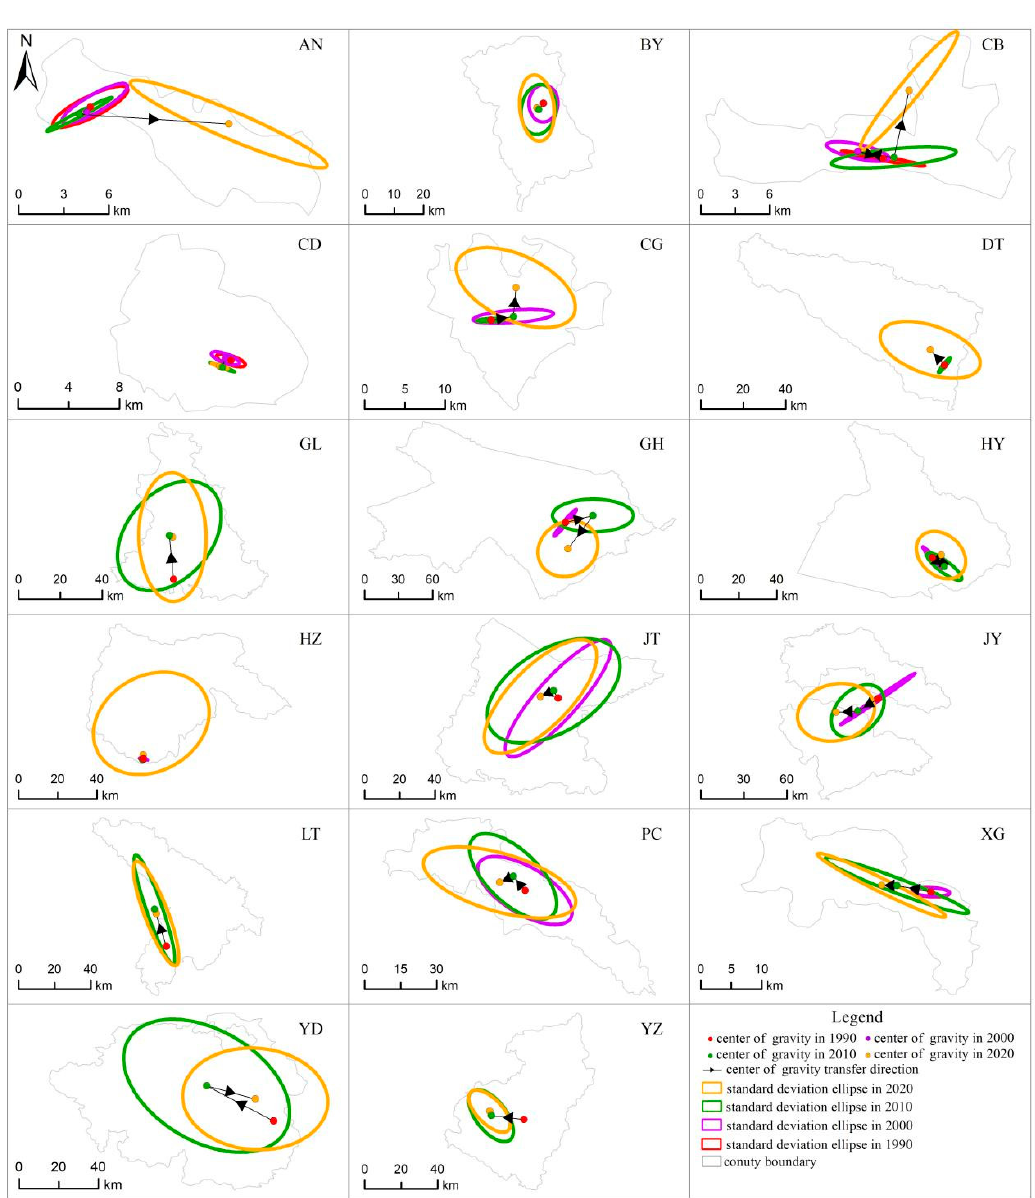
Figure 9. Distributions of central other construction land shifts at the county level in the study area from 1990 to 2020.